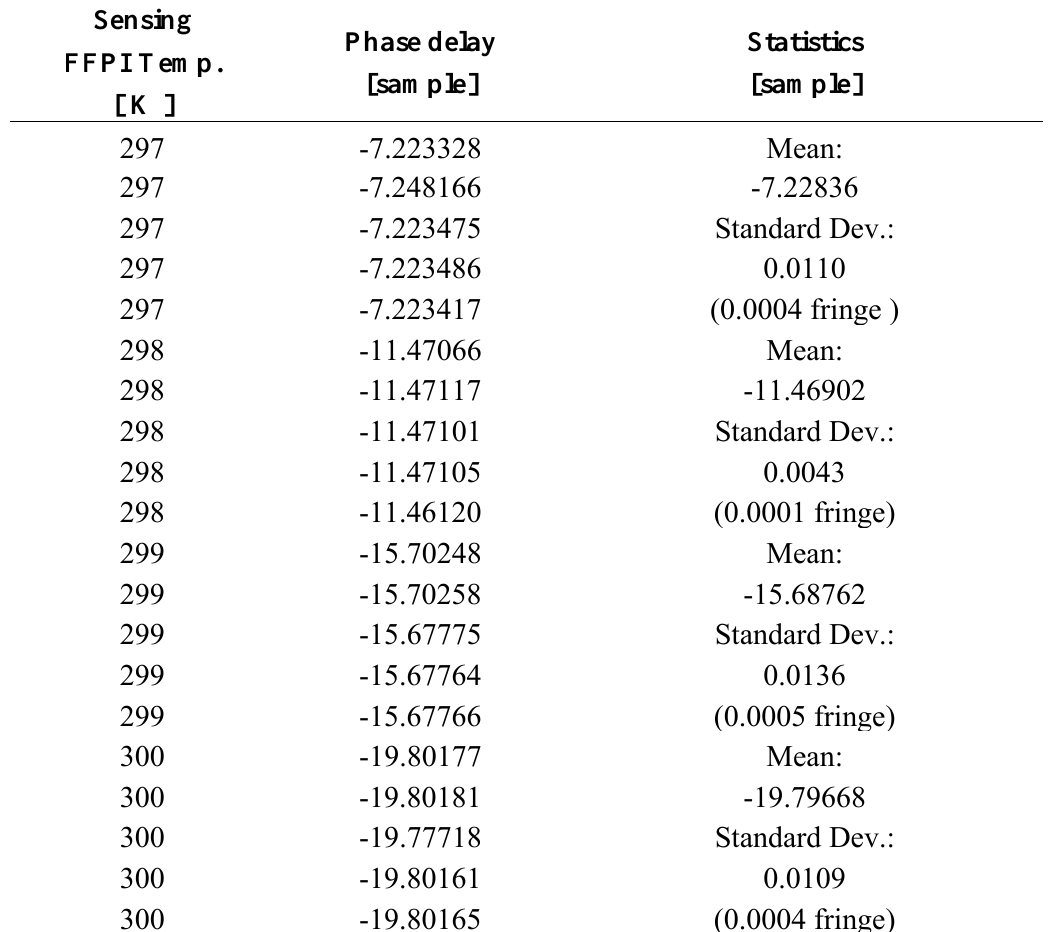
Table 2 . Phase delay ΔΦ i of absolute temperature measurement.